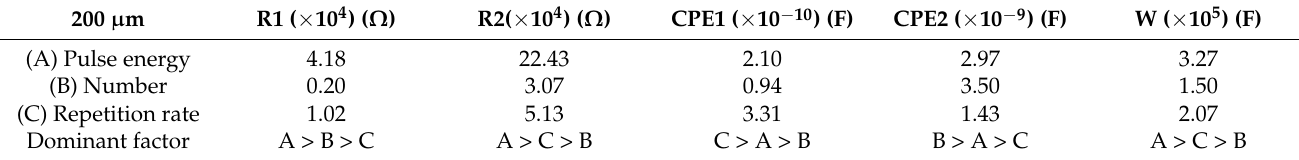
Table 10. The range analysis data for 200-diameter circular template from the key components of equivalent circuit